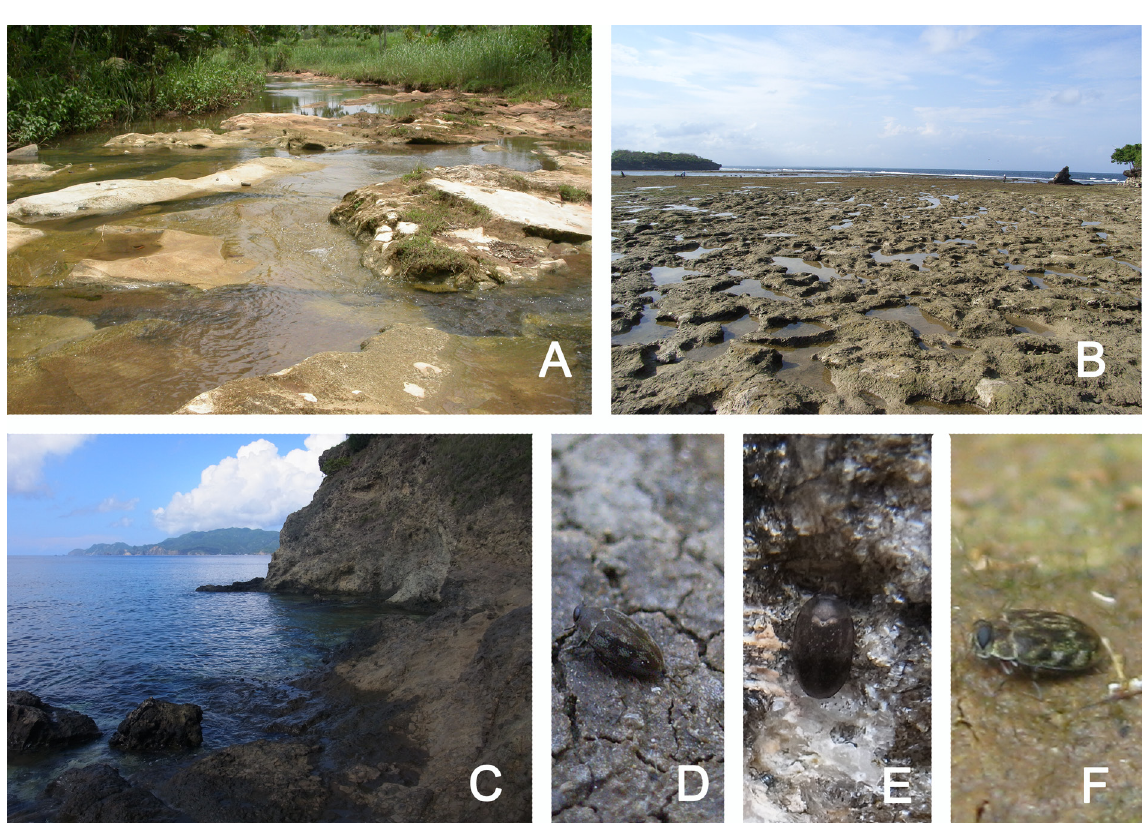
Fig. 4. Habitats (A–C) and living adults (D–F) of Asian Thaumastodinae Champion, 1924. A . Dondong River, Pengkol, Yogyakarta special Region, Java, Indonesia (type locality of Acontosceles javanicus Yoshitomi & Putra, 2011 (F) and Pseudeucinetus javanicus Yoshitomi & Putra, 2010 (D)). B . Nusa Dua, Bali, Indonesia (type locality of Mexico baliensis sp. nov.). C . Hirashima, Ogasawara, Japan (type locality of Mexico ogasawaraensis sp. nov.). D . Type locality of Pseudeucinetus javanicus Yoshitomi & Putra, 2010. E . Mexico masamii (Satô, 1994) in Shikinejima, Izu Islands. F . Type locality of Acontosceles javanicus Yoshitomi & Putra,